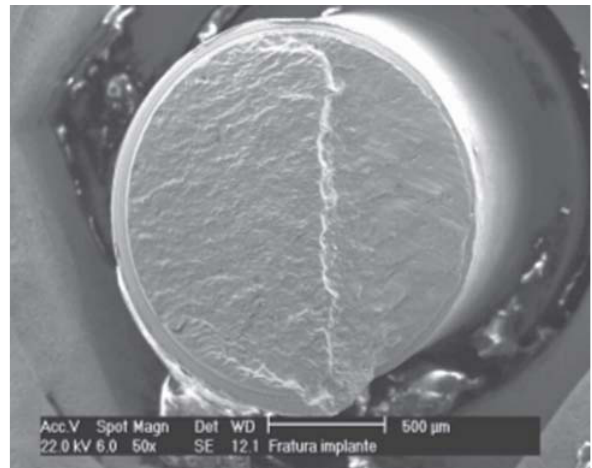
FIGURE 1- First fractured screw (initial fracture caused by shear and compressive strengths). The step demonstrates fracture in two phases